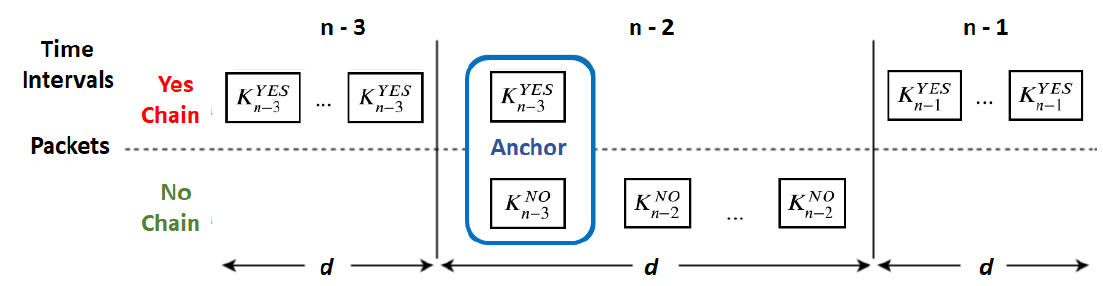
Figure 4. Example of an intermediate anchor message transmitted for time interval n